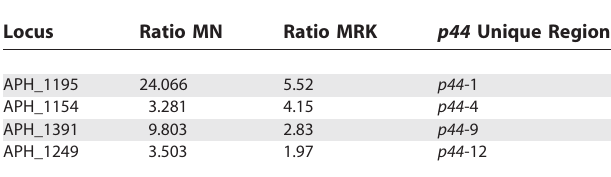
Table 4. Selected A. phagocytophilum CGH Results